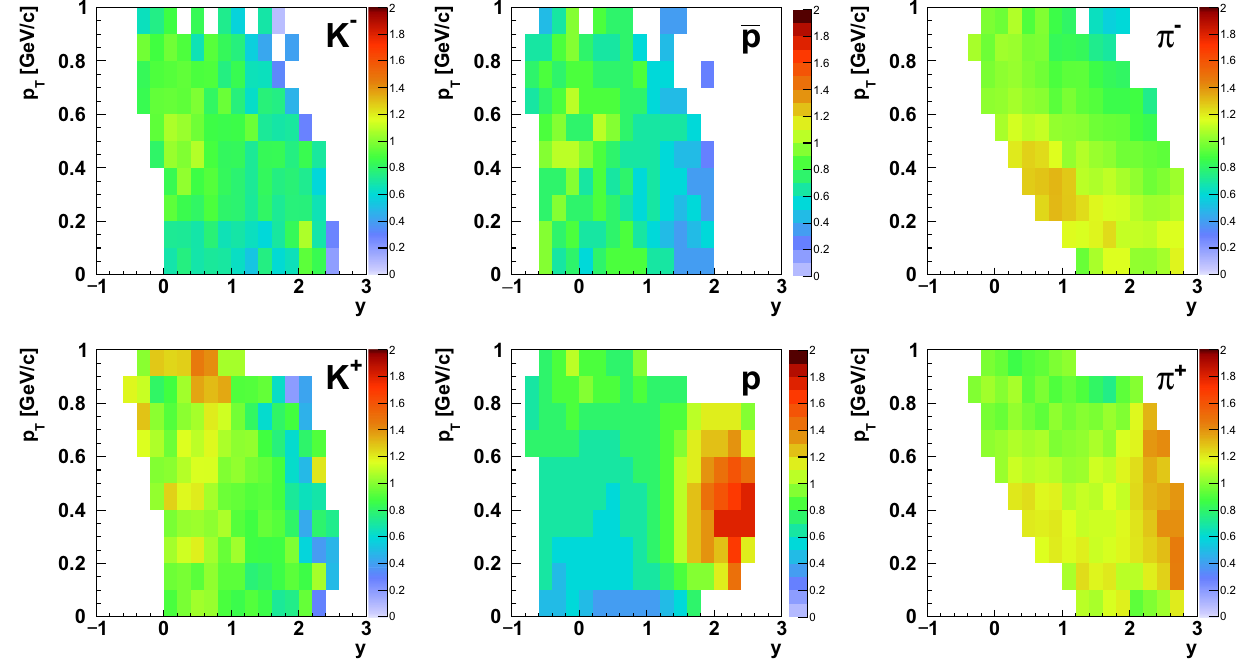
Fig. 42 Two dimensional distributions d 2 n /( dp T dy ) of π − , π + , K − , K + , p and ¯ p produced in inelastic p + p interactions at 158 GeV / c divided by the U r QMD 3.4 model [27,28]